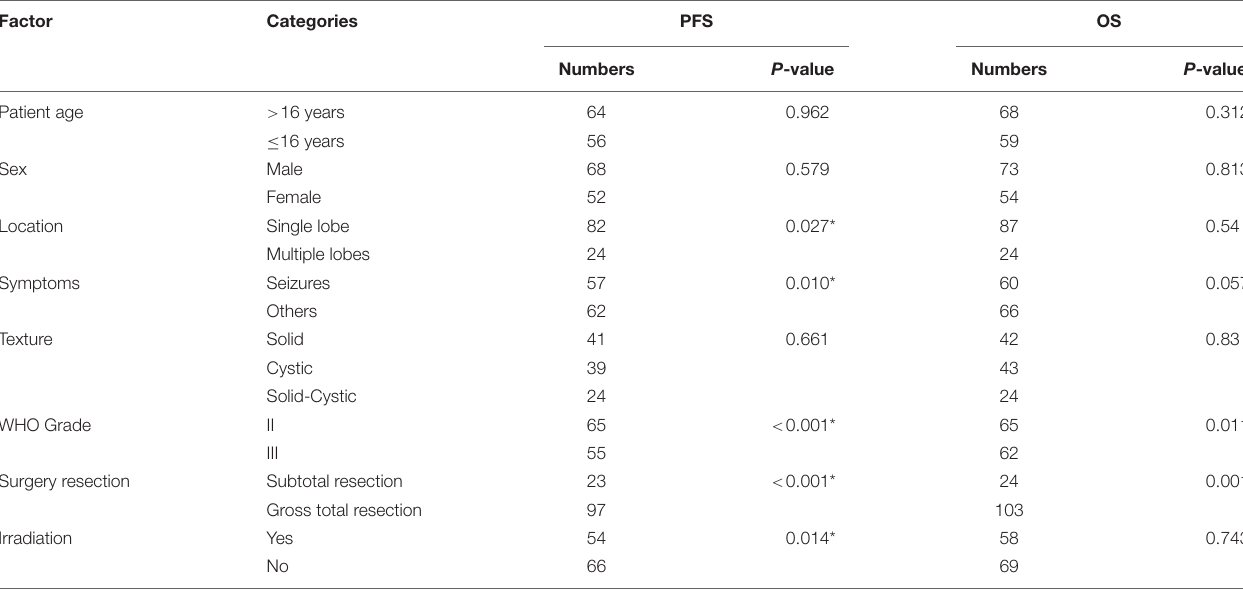
TABLE 4 | Univariate analysis of prognostic factors for PFS and